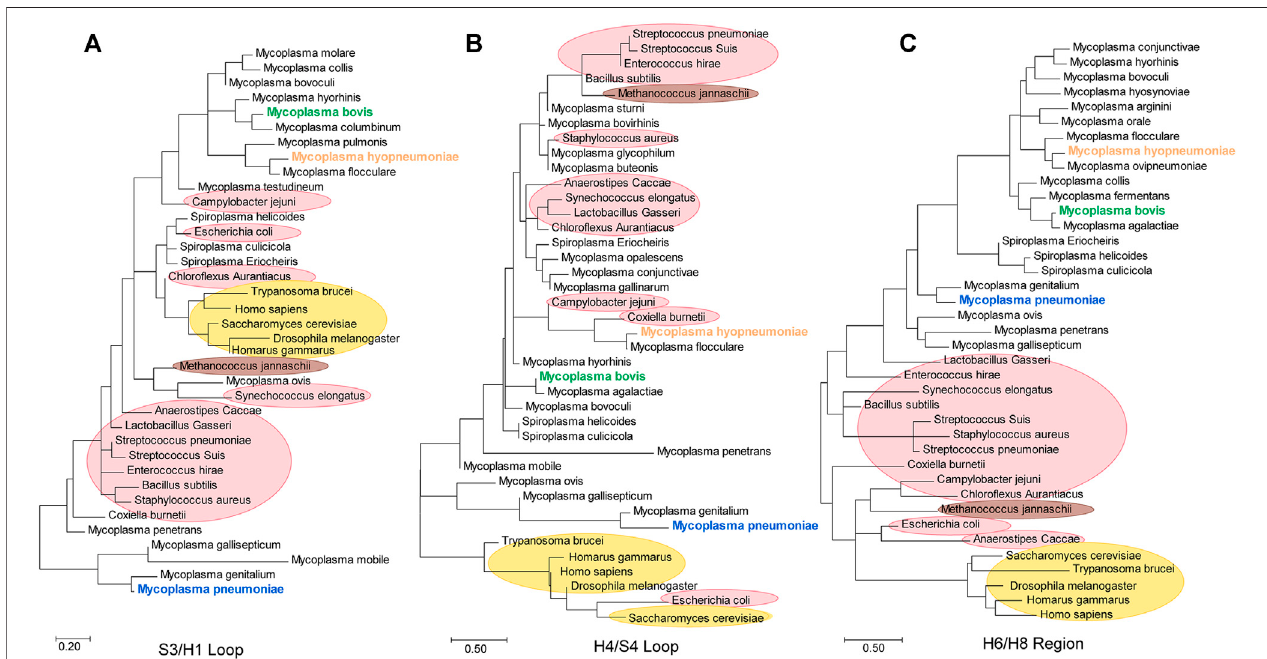
FIGURE 8 | Phylogenetic trees generated from the S3/H1 loop, H4/S4 loop and H6/H8 regions of enolases from